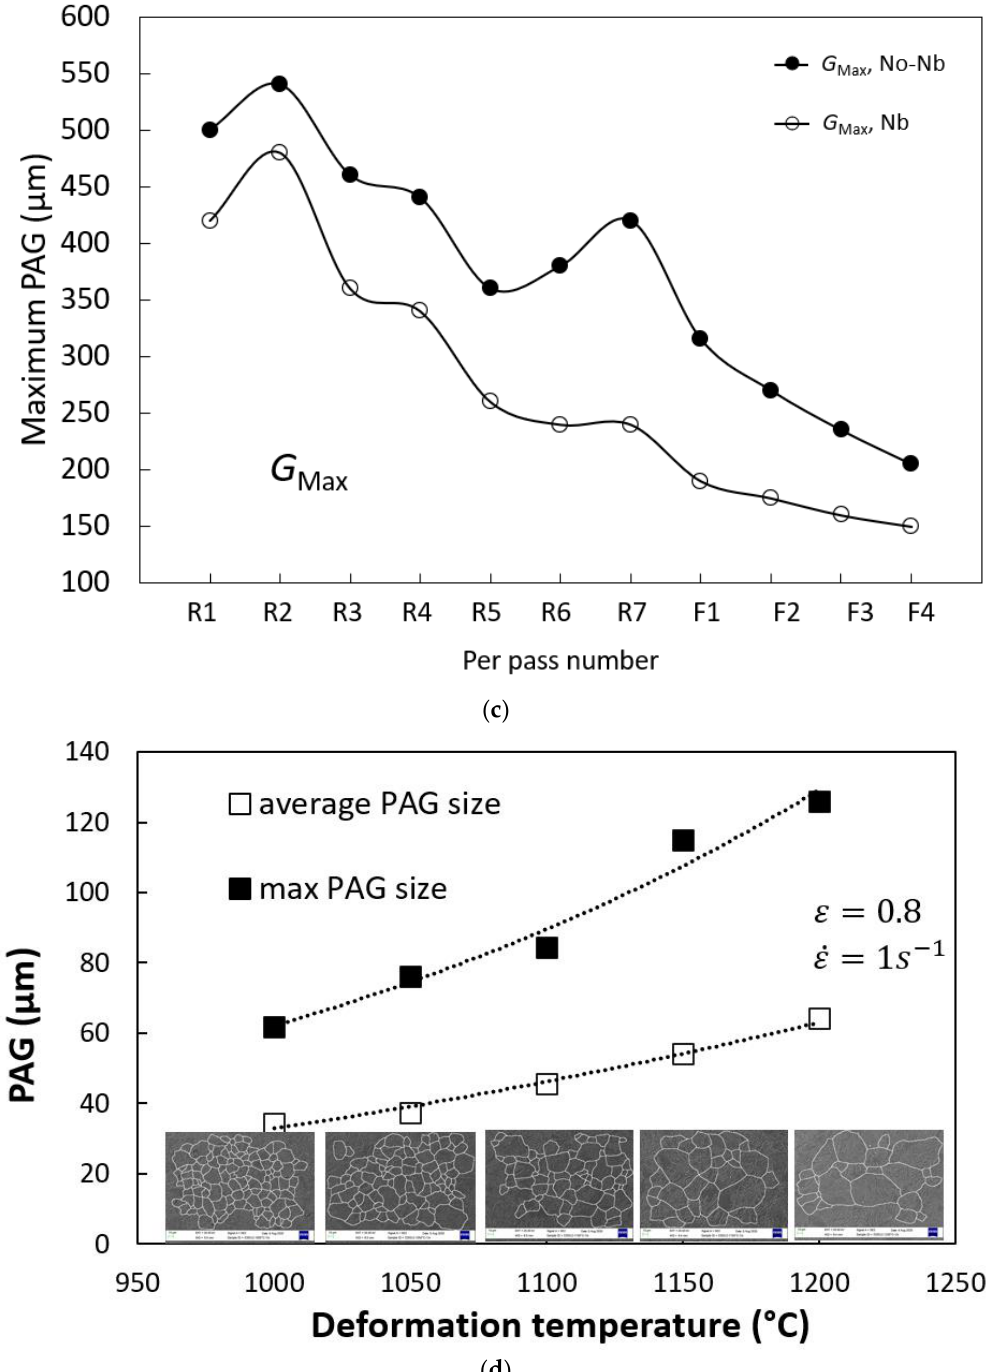
Figure 7. High-temperature (SRX) grain size evolution predicted with MicroSim: ( a ) Influence of reheating temperature on average PAG and ( b ) the variation of maximum PAG distribution. ( c ) Influence of added Nb on maximum PAG at lowest reheating temperature (1180 – 1200 °C). ( d ) Lower limit G Avg and G Max as a function of deformation temperature at fixed low strain rate 1 s − 1 and high per-pass strain, 𝜀 = 0.8 , determined using thermomechanical simulator Gleeble 1500D for up to 0.01% Nb.